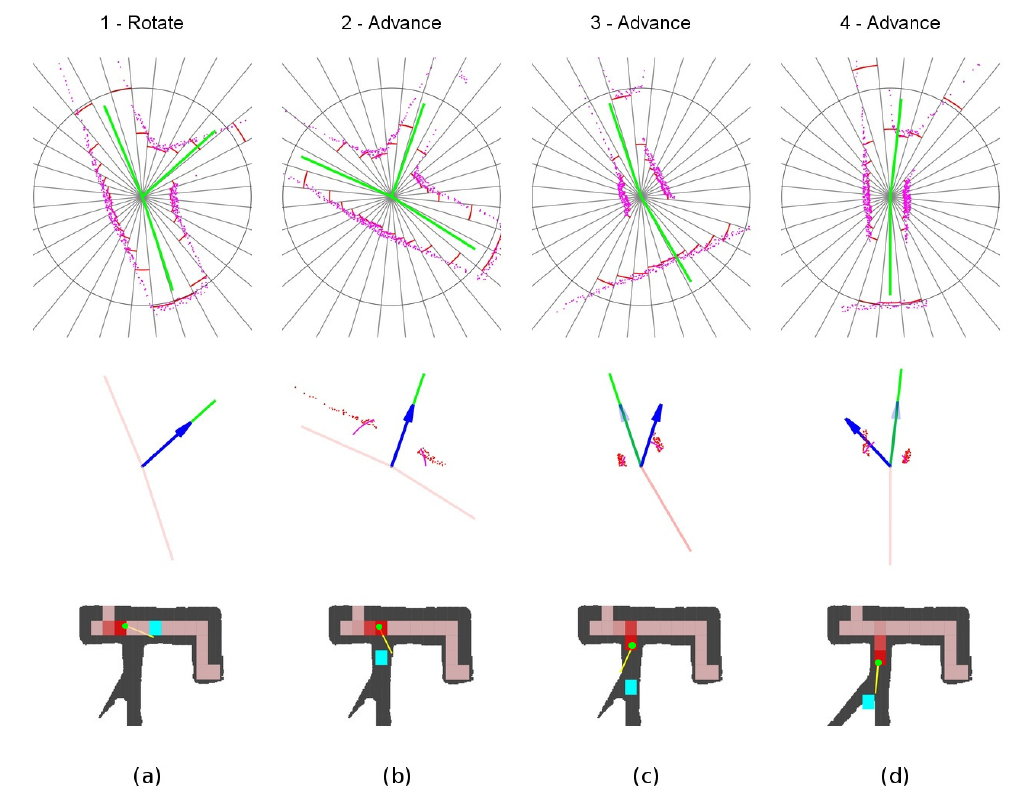
Figure 20. Explored three-way crossing secuence of events. ( a ) Location 1. ( b ) Location 2. ( c ) Location 3. ( d ) Location 4.